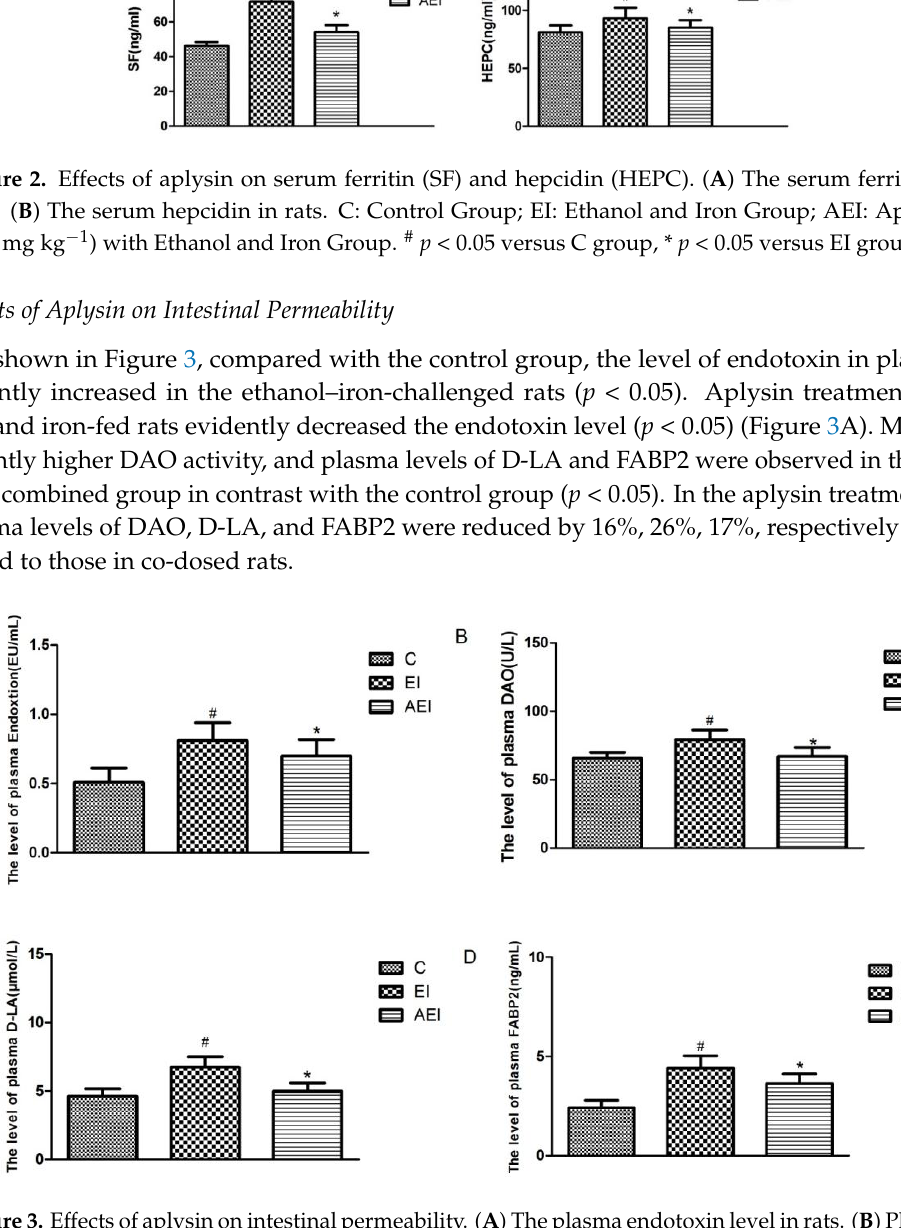
Figure 3. Effects of aplysin on intestinal permeability. ( A ) The plasma endotoxin level in rats. ( B ) Plasma diamine oxidase (DAO) level in rats. ( C ) Plasma D-lactic acid (D-LA ) level in rats. ( D ) Plasma fatty acid-binding protein 2 (FABP2) level in rats. C: Control Group; EI: Ethanol and Iron Group; AEI: Aplysin (150 mg kg −1 ) with Ethanol and Iron Group. # p < 0.05 versus C group, * p < 0.05 versus EI group.